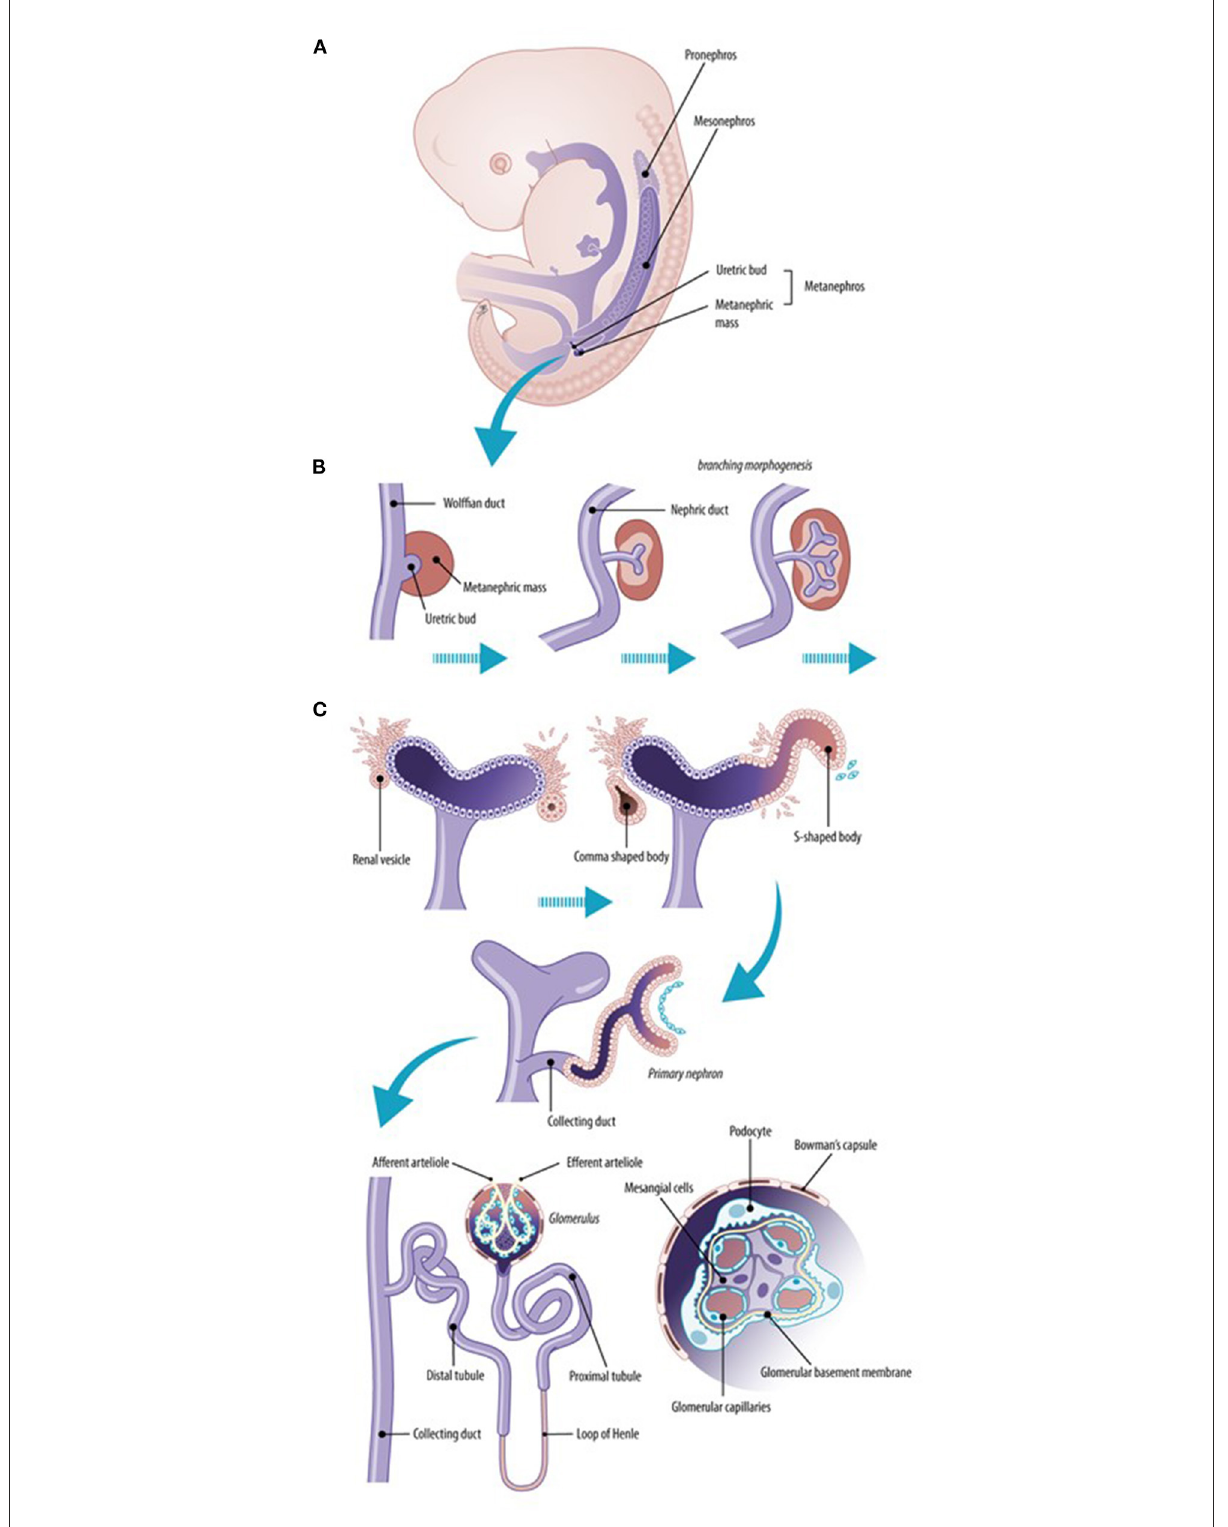
FIGURE1 Normal renal development. The early ureteric bud interacts with the metanephric mesenchyme to form the pronephric duct (pronephros). The more caudal mesonephric ducts are the first “glomeruli–like” structures (mesonephros) that form transiently active filtration units while the metanephros is created (A) . Early development of the kidney implies branching morphogenesis (B) through the interaction between the ureteric bud and the metanephric mass. The metanephric mass undergoes mesenchymal–to–epithelial transformation to form nephrons, including the glomeruli and tubuli (C) . The final nephron number is attained at about 34–36 weeks of gestational age (10-fold variability,